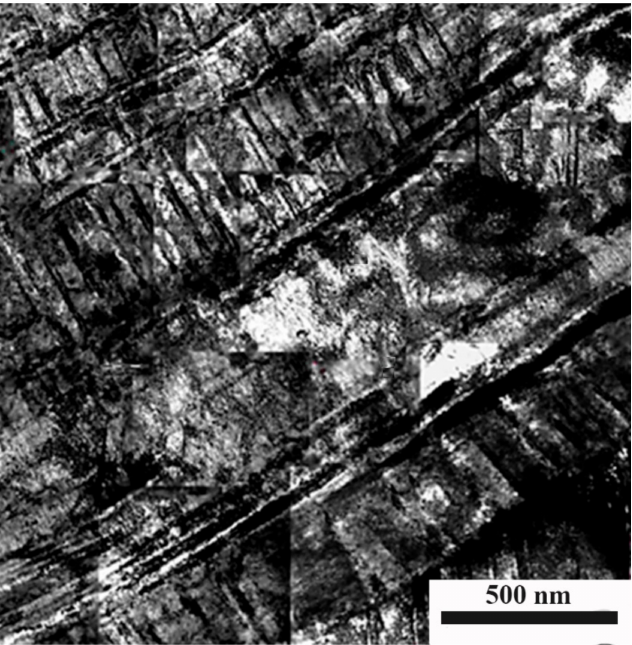
Figure 2. A panoramic TEM image (bright field) of the TWIP steel after two ECAP passes. The image is composed of about 15 standard TEM images stuck